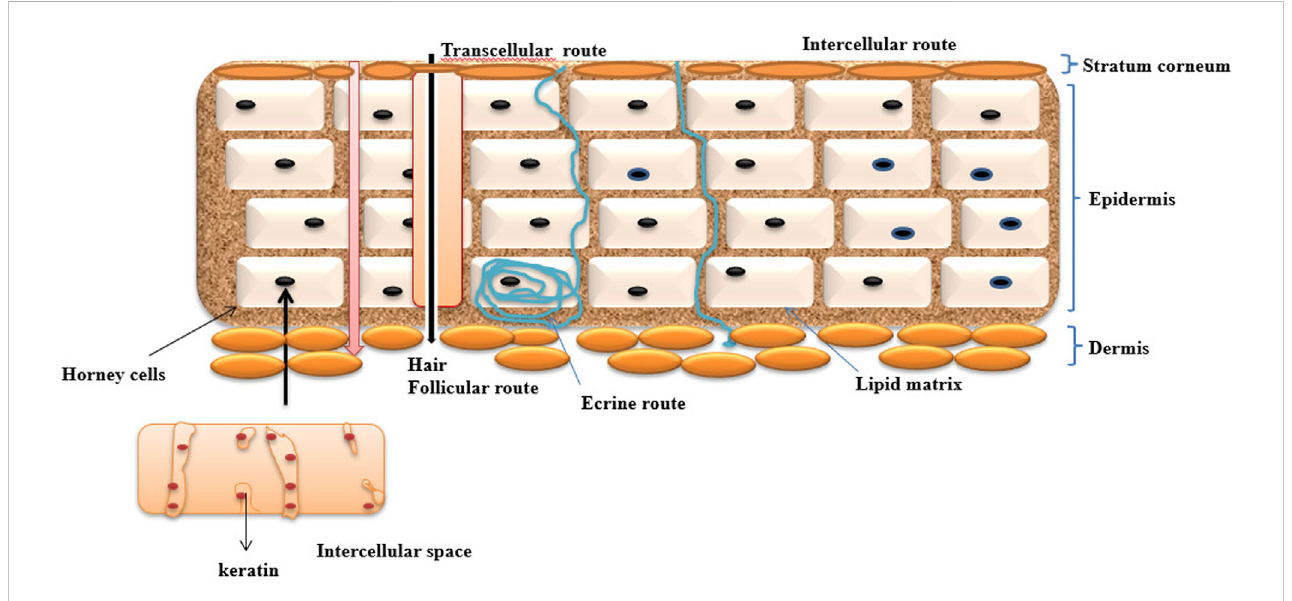
FIGURE 1 Structure of skin layer.